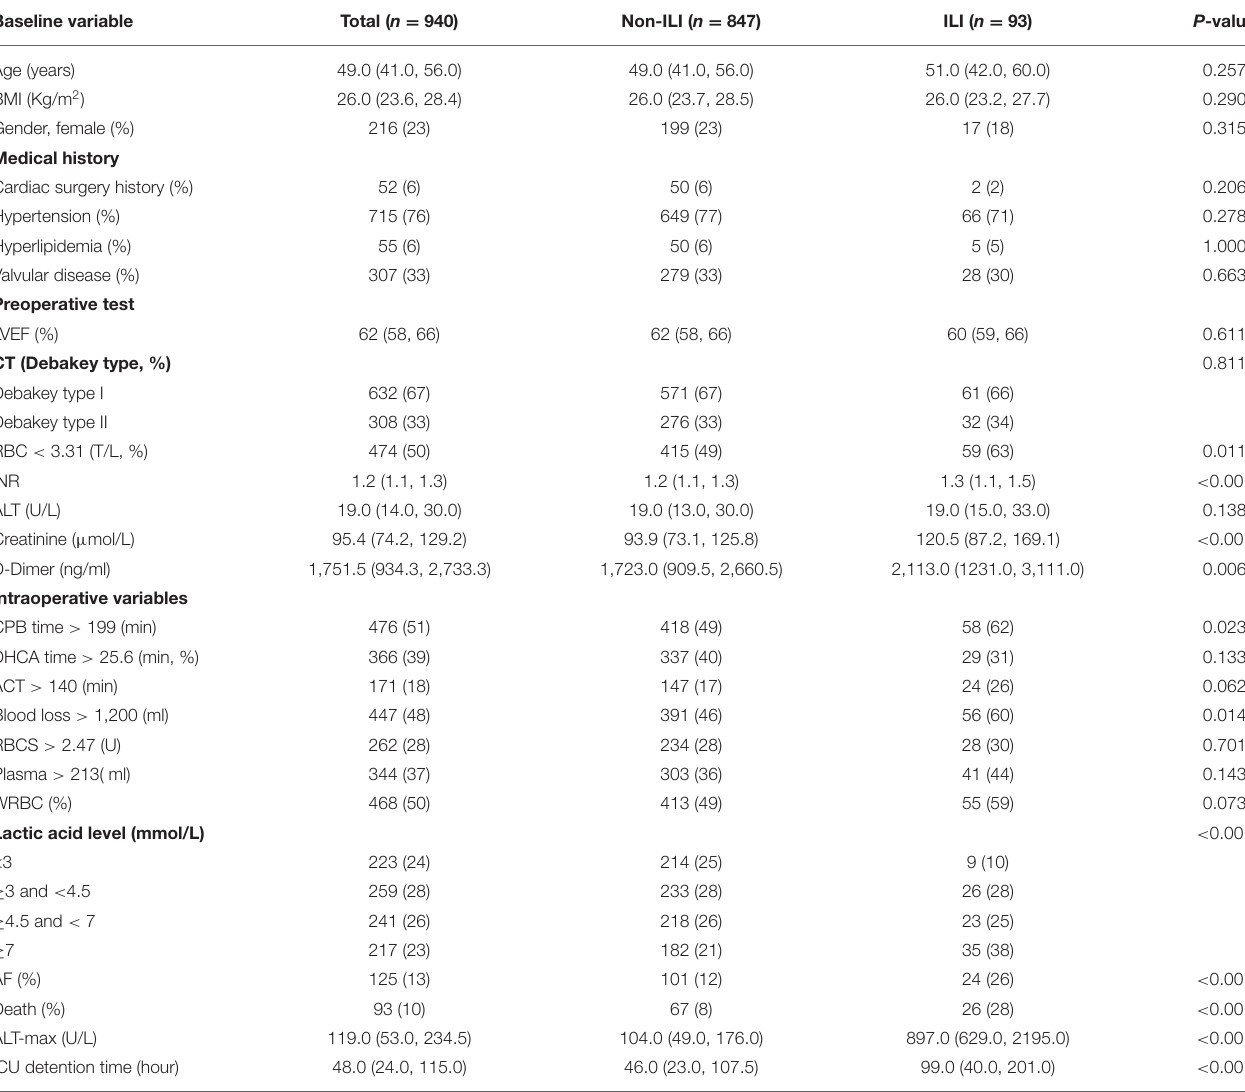
TABLE 1 | Baseline characteristic of the 1,343 AAD